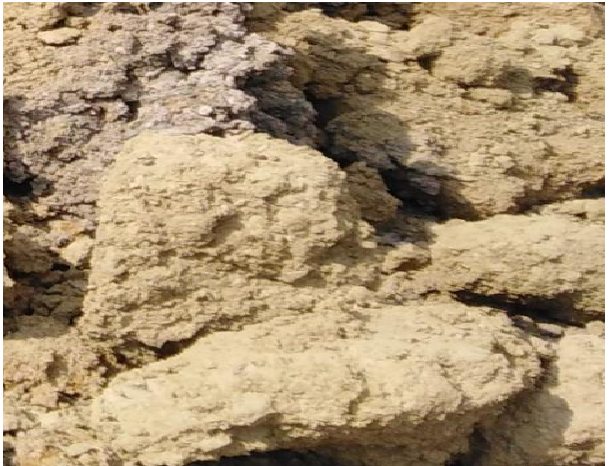
Figure 1. Diatomite